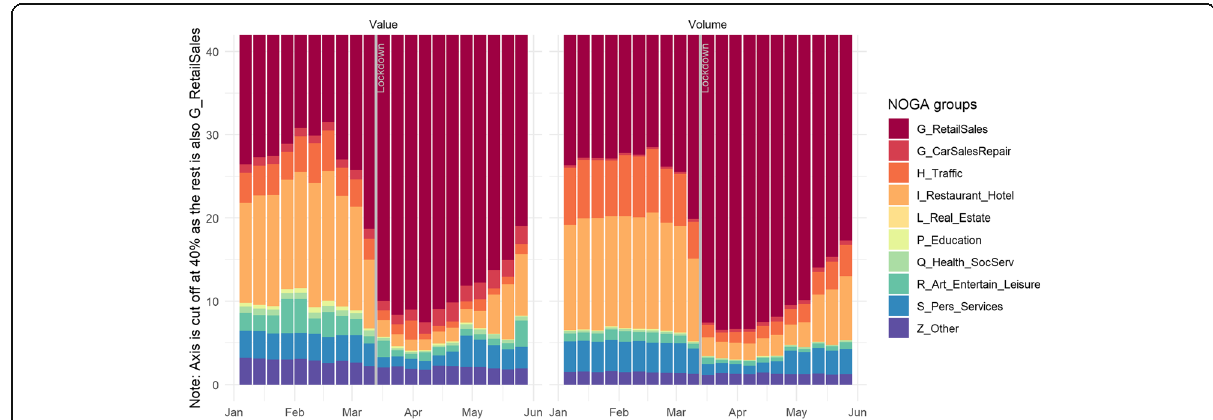
Fig. 2 Shares of the NOGA 2 groups for value and volume in total card payments, measured by weekly averages for the period January to May 2020. Source: Own calculations,